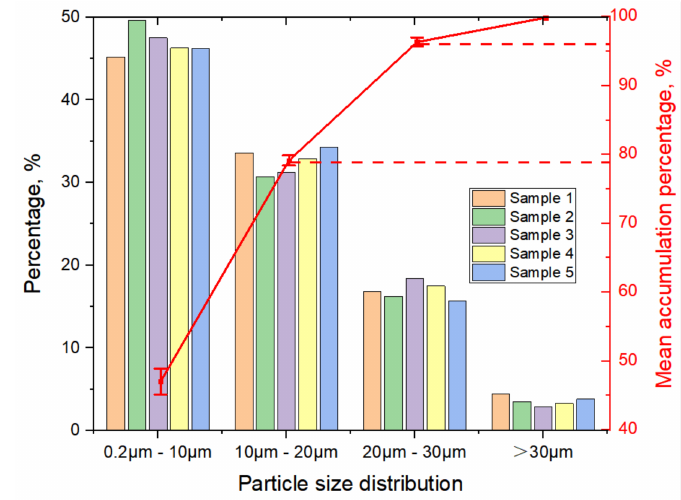
Figure 6. Particle size distribution of the coal powders.